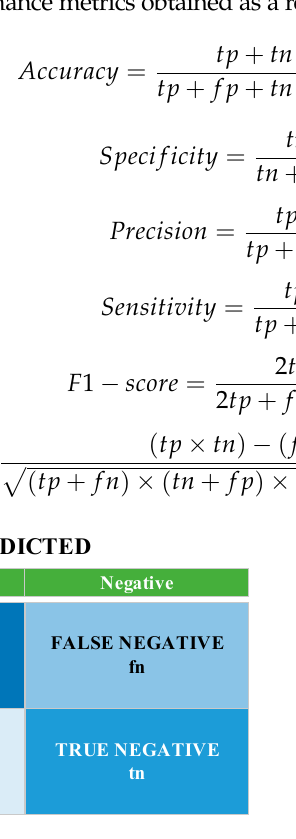
Figure 12. Structure of confusion matrices.